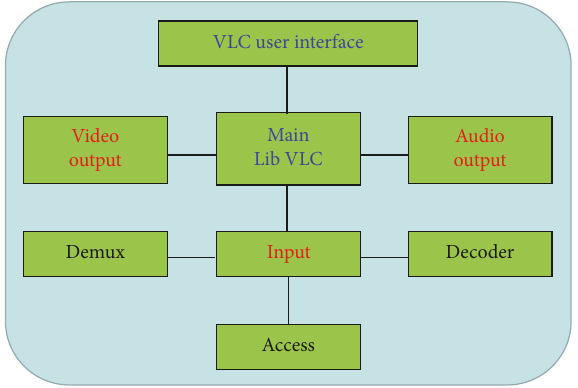
Figure 2: Architecture of VLC ActiveX package.